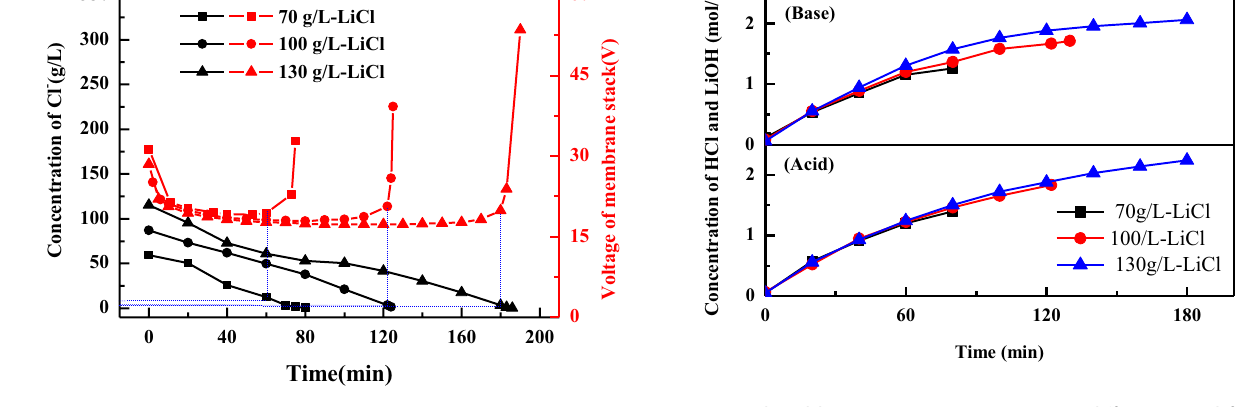
Fig. 2 Variation of stack voltage and Cl- concentration